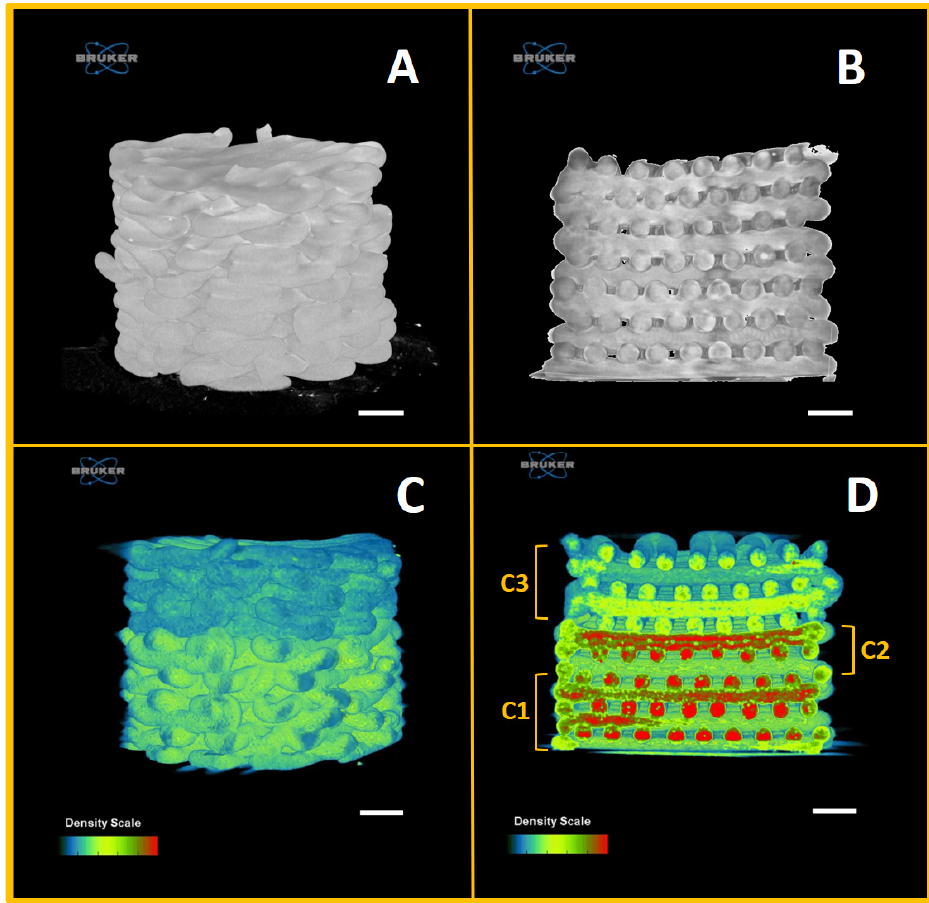
Figure 5. microCT reconstructions of: ( A ) PCL scaffold, ( B ) PCL scaffold cross section, ( C ) multi-layer PCL/Sr-nHA scaffold and ( D ) multi-layer PCL/Sr-nHA scaffold cross section where the C1, C2 and C3 compartments are indicated.